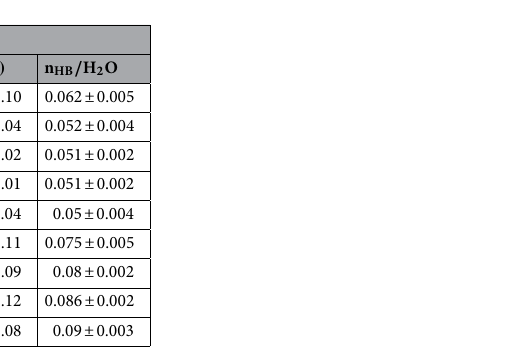
Table 2. Number of HB bonds per water molecule and the corresponding water dipolar relaxation time for confined water and NaCl solution in both PG and GO channels.